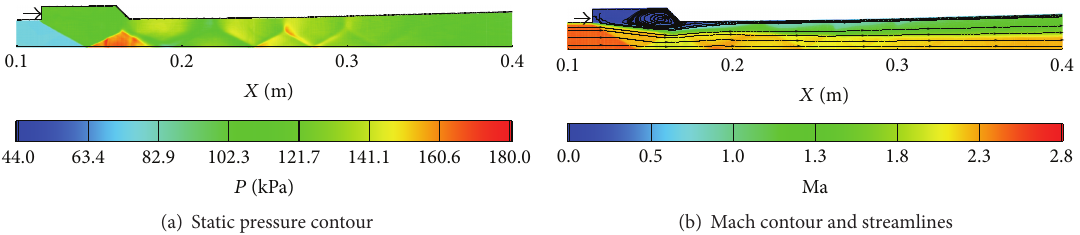
Figure 5: Detailed flow field for Case 2.